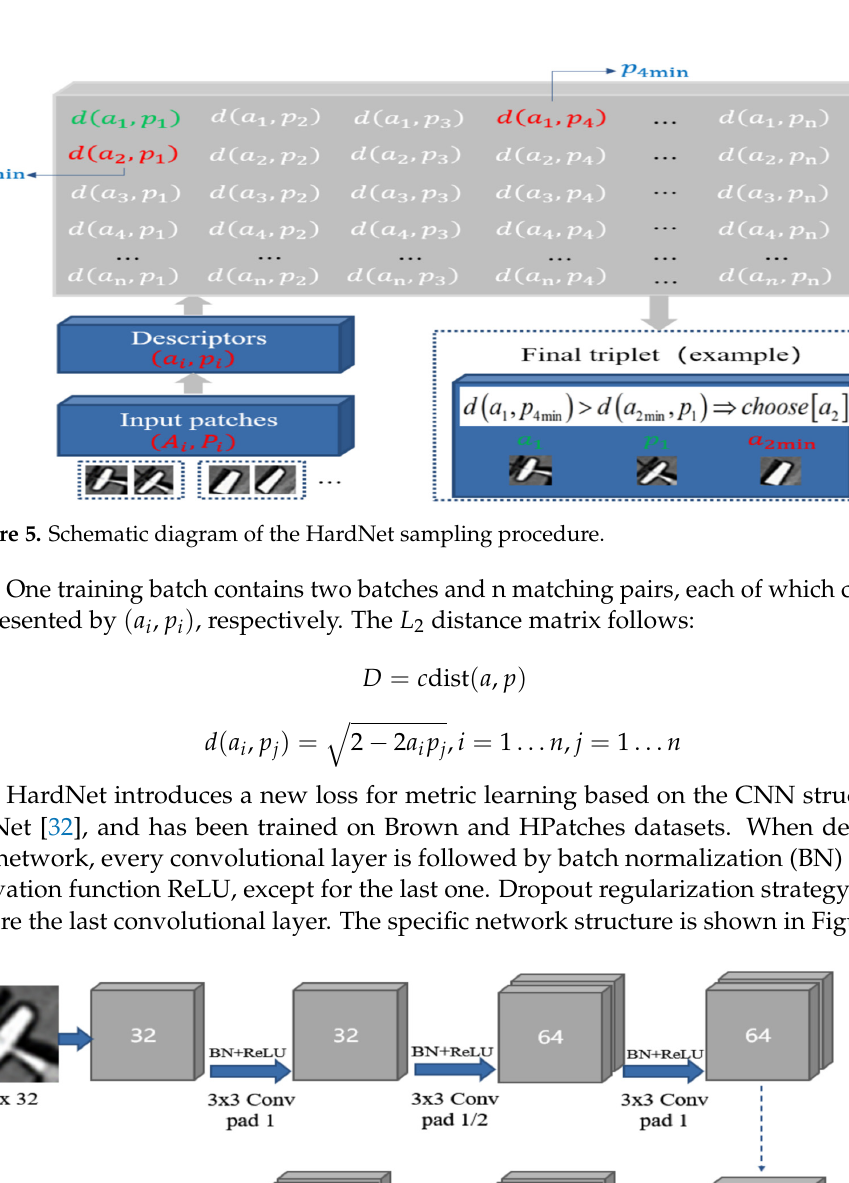
Figure 6. The network architecture of HardNet.